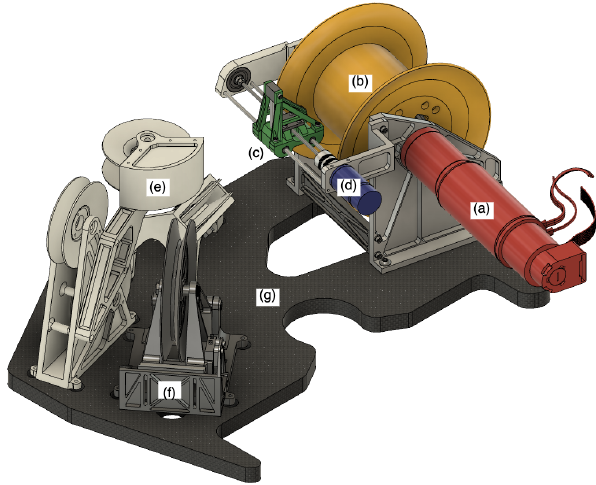
Figure 2. Rendering of the RACHuTS reel system. Major assem- blies include the primary drivetrain ( a , red), reel ( b , yellow), level wind carriage ( c , green), level wind motor ( d , blue), line redirection pulley train ( e , white), kinematic pulley ( f , grey), and carbon fiber baseplate ( g , black twill). The line, electronics box, and docking connector are not shown. The line is routed from the reel, through the level wind, around the redirection pulleys to align with the kine- matic pulley, exiting the gondola through the hole in the baseplate (near f